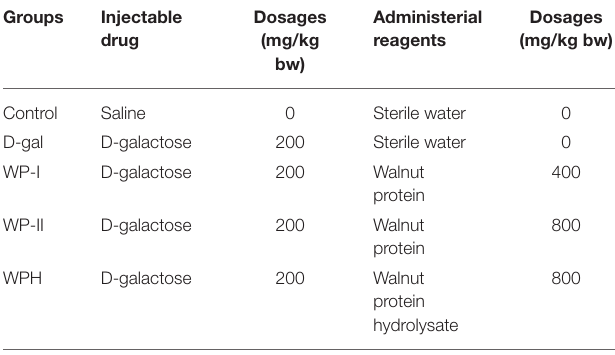
TABLE 1 | Animal grouping and experimental design.